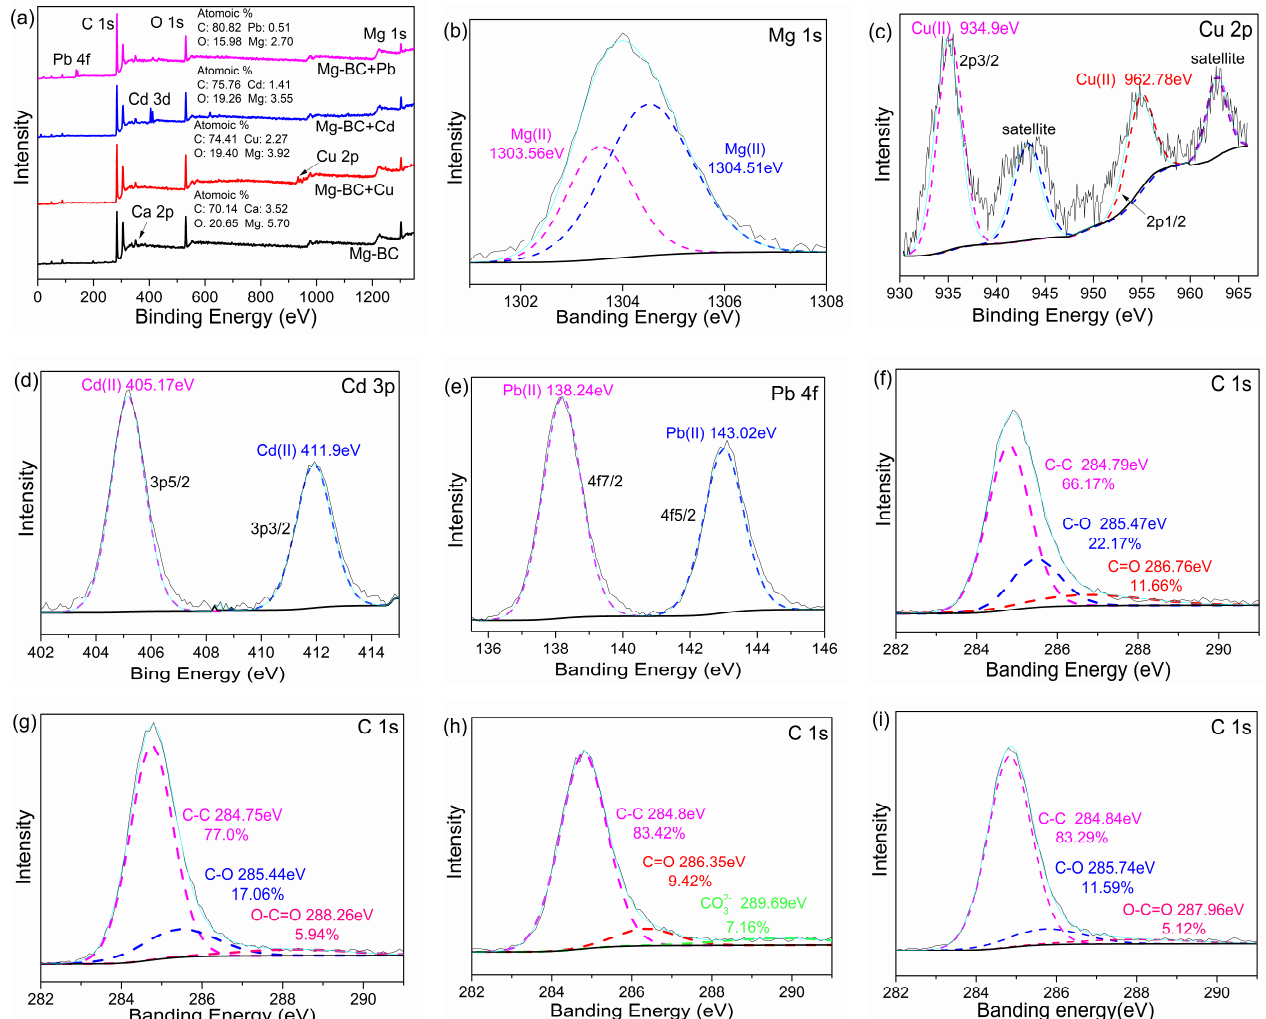
Figure 8. X-ray photoelectron spectroscopy (XPS) spectra (full scan) ( a ), 15%Mg-BC ( b , f ), and Cu- ( c , g ), Cd- ( d , h ) and Pb-coated biochars ( e , i ).